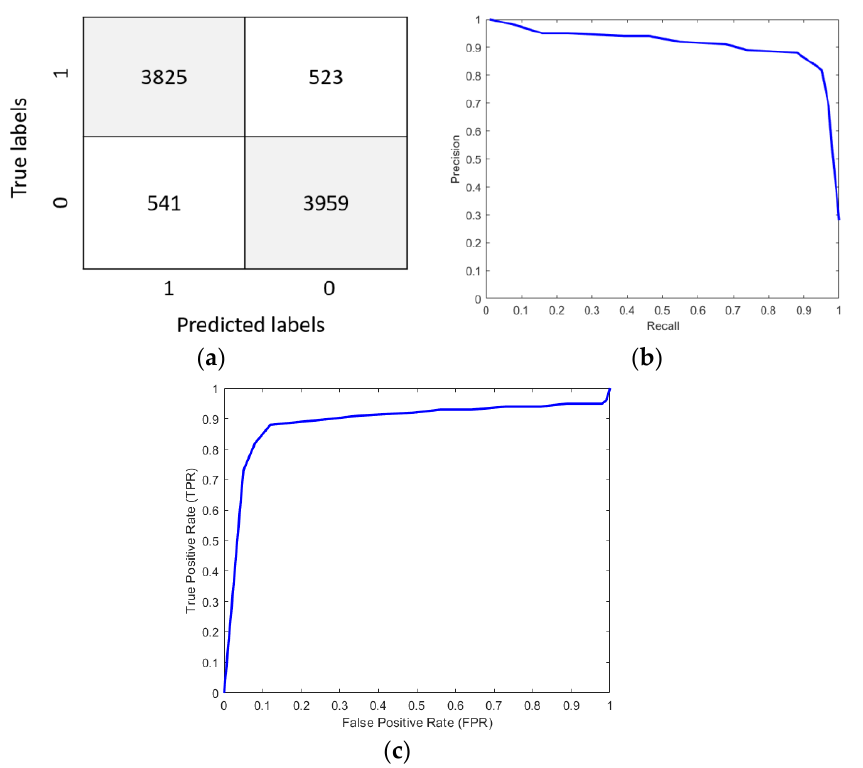
Figure 17. Method 2 evaluation. ( a ) Confusion matrix. ( b ) PR curve. ( c ) ROC curve.